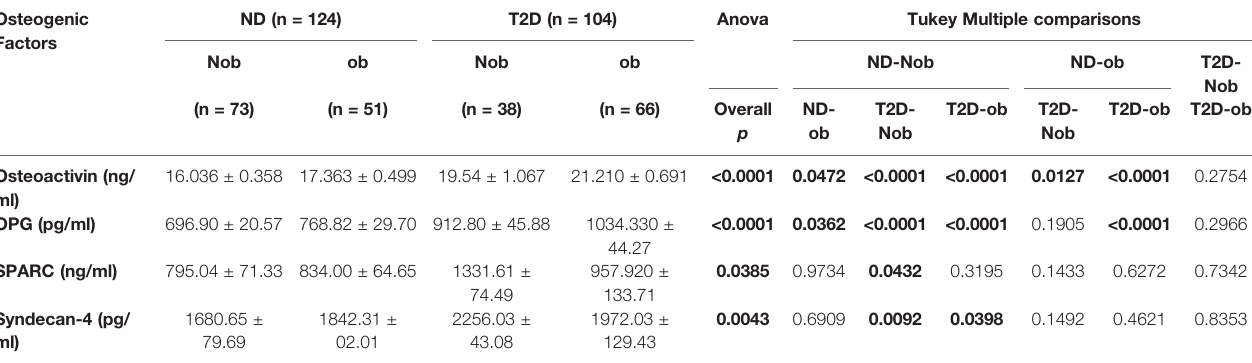
Data are presented as mean ± SEM. One-way ANOVA test was used to compare the level of various osteogenic molecules across different groups. Tukey post-hoc analysis was performed to compare the groups. Bold values indicate statistically signi fi cant